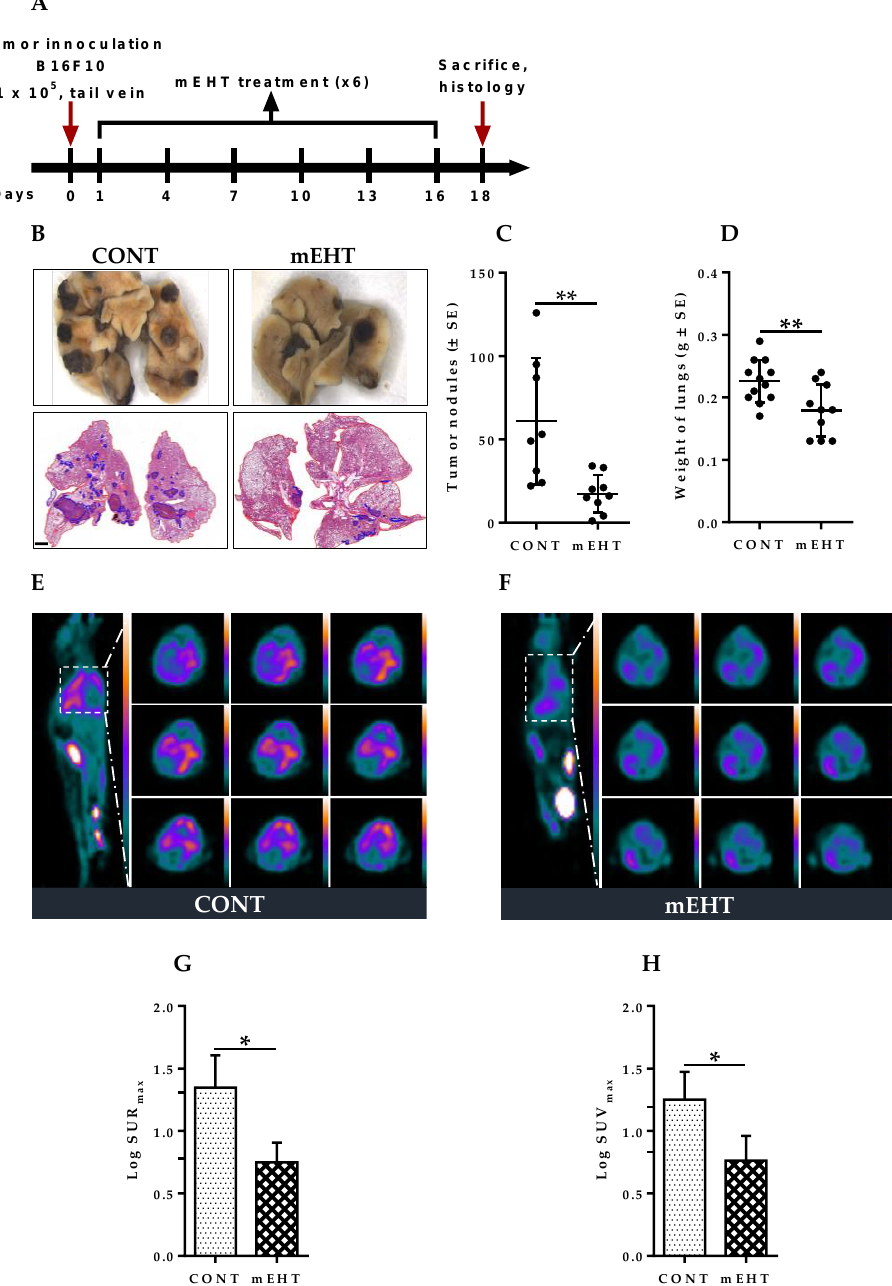
Figure 3. Effect of modulated electrohyperthermia on tumor burden in mouse lungs. ( A ) Schematic representation of the experimental protocol. Animals were injected with 1 × 10 5 B16F10 melanoma cells via tail vein and treated six times with LabEHY-200; ( B ) Native and H&E stained lungs with pulmonary melanoma metastatic in CONT and mEHT-treated animals, (Scale bar, 2000 μm); ( C ) Quantification of pulmonary melanoma metastatic nodules in CONT ( n = 8) and mEHT ( n = 9); ( D ) Quantification of lung weight in CONT ( n = 12) and mEHT ( n = 10); ( E , F ) Representative PET images depicting [ 18 F]FDG uptake in sagittal and coronal sections of CONT and mEHT; ( G ) Standardized uptake ratio (SURmax) of [ 18 F]FDG in CONT ( n = 4) and mEHT ( n = 3); ( H ) Standardized uptake value (SUVmax) of [ 18 F]FDG in CONT ( n = 4) and mEHT ( n = 3). Data represent average ± SEM. ( C , D ) CONT vs. mEHT, unpaired t -test, ( G , H ) CONT vs. mEHT, Mann–Whitney test. * p < 0.05, ** p < 0.01.